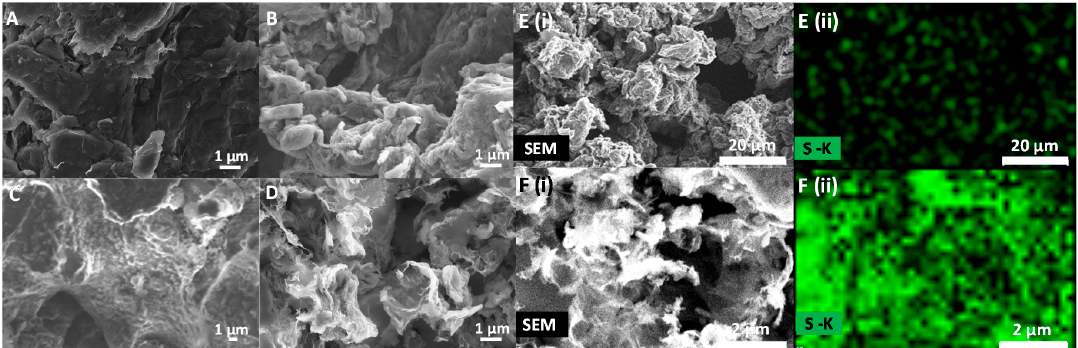
Figure 2. Scanning electron micrographs (SEM) of the morphology of different graphene-containing samples. ( A ) Graphene oxide; ( B ) chemically reduced graphene oxide (CRGO); ( C ) graphene-sulfur composite (GS1); ( D ) graphene-oxide composite 2 (GS2); ( E ) (i) Corresponding SEM of CRGO (ii) SEM-EDXS mapping for sulfur (S-K line) of CRGO; ( F ) (i) Corresponding SEM of GS2 (ii) SEM-EDXS (Elemental Dispersive X-ray Spectroscopy) mapping for sulfur distribution (S-K line) of GS2.